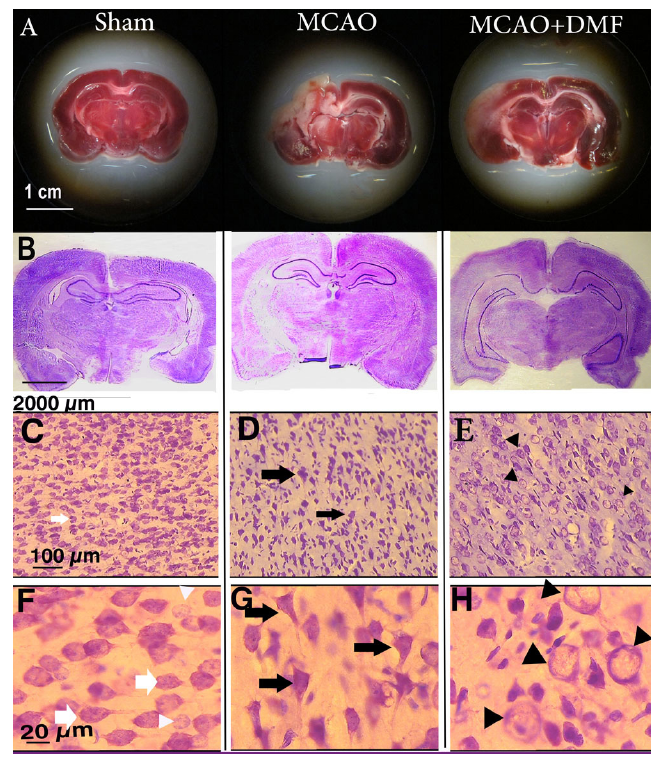
FIGURE 4 - A, a representative TTC-stained cerebral tissue section in normal uninjured (sham), vehicle, and DMF-treated MCAO rats, the normal uninjured area appears in red, while infarct area in the right (ischemic) hemisphere does not stain with this color and appears white. B, In cresyl violet staining, the normal area in both hemispheres appears in dark blue to purple, while the infarct area in the right (ischemic) hemisphere does not stain with this color and appears very pale blue to white. C and F, Representative cresyl violet-stained photograph of the right cerebral cortex in sham surgery group with normal neurons (white arrow) and non-neuron cells (white arrowhead); D and G, Rats that were subjected to MCAO and treated with vehicle showed frequent shrinkage and pyknotic (dead) cells (Black arrow); E and H, DMF treatment group after MCAO show less dead neuron (black arrow); however, hypertrophied neurons appeared (black arrowhead). DMF, Dimethyl fumarate; MCAO, middle cerebral artery occlusion; TTC, 2, 3, 5-triphenyltetrazolium